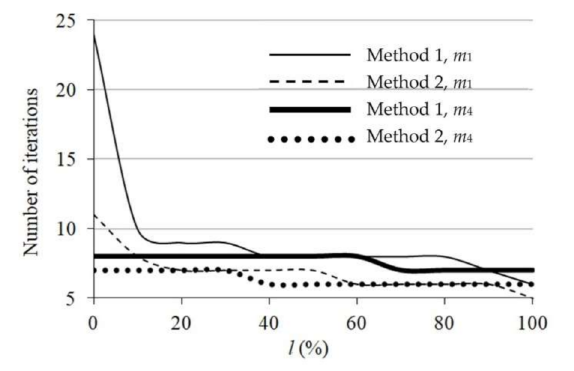
Figure 8. The number of iterations in the state-estimation process for load level V 1.5